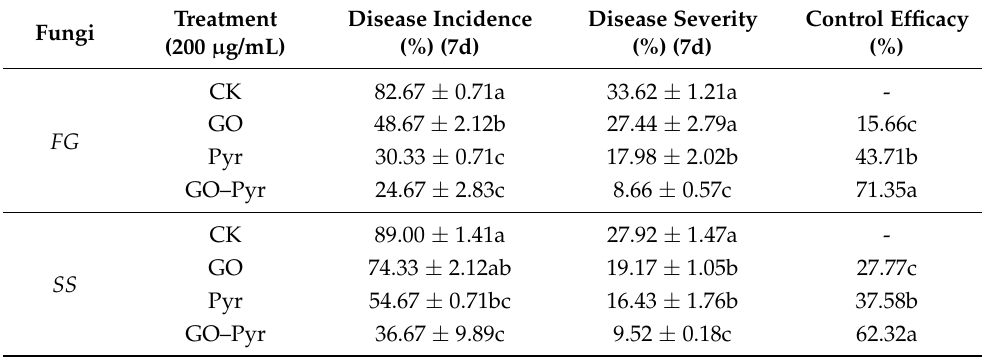
Table 4. Control efficacy of GO, Pyr and GO–Pyr nanocomposite on FG and SS under greenhouse conditions (25 ◦ C and 85% humidity).